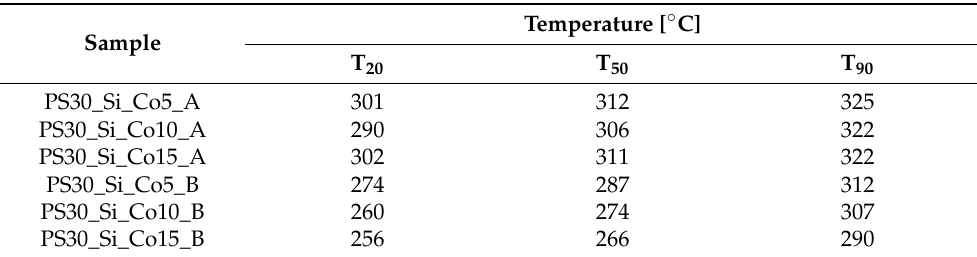
Figure 9. ( a ) Toluene conversion achieved at various temperatures over PS30_Si-based catalysts compared to the reference Co15/silica sample, and ( b ) rate of the toluene combustion at 275 °C calculated in relation to Co content. Table 2. Temperatures at which 20, 50 and 90% toluene conversion was achieved in the toluene combustion over PS30_Si-based catalysts.